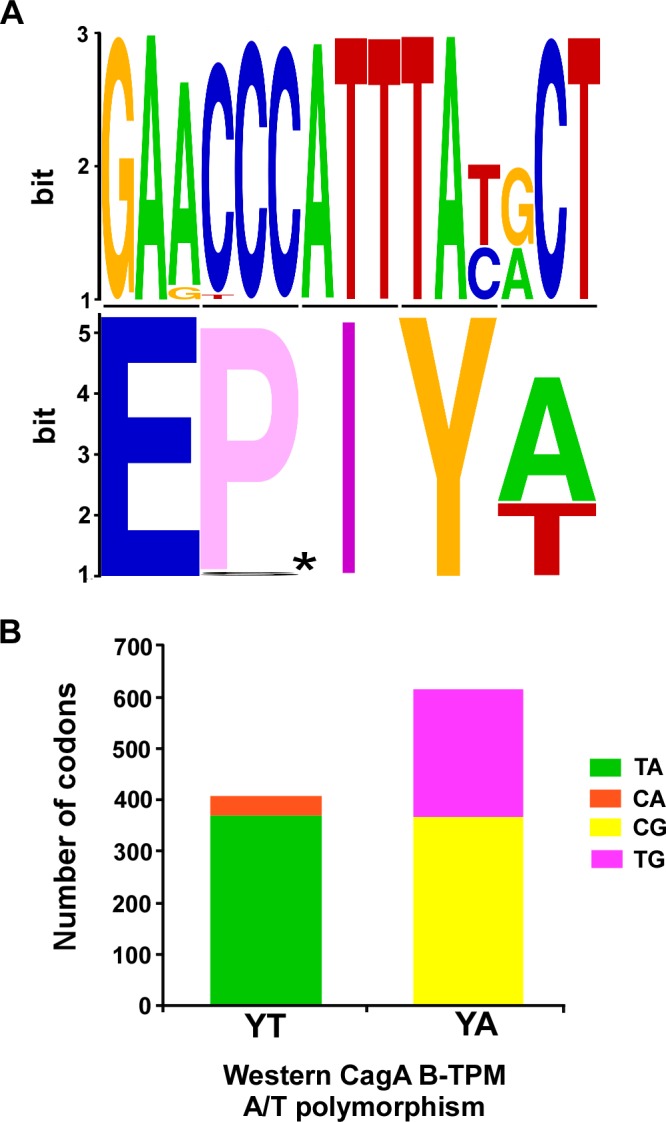
Polymorphisms of the Western CagA B-TPMs and their codons.
Panel A: The sequences for 1027 Western CagA B-TPMs were aligned and a sequence logo was produced (upper), and amino acids (lower, *: E-P/S-I-). Panel B: The distribution of codons for the Western CagA B-TPM YA and YT polymorphisms. The proportions of major (TA) and minor (CA) codons of YT are significantly different (p<0.0001). The proportions of major (CG) and minor (CA) codons of YA and also are significantly different (p = 0.0075).